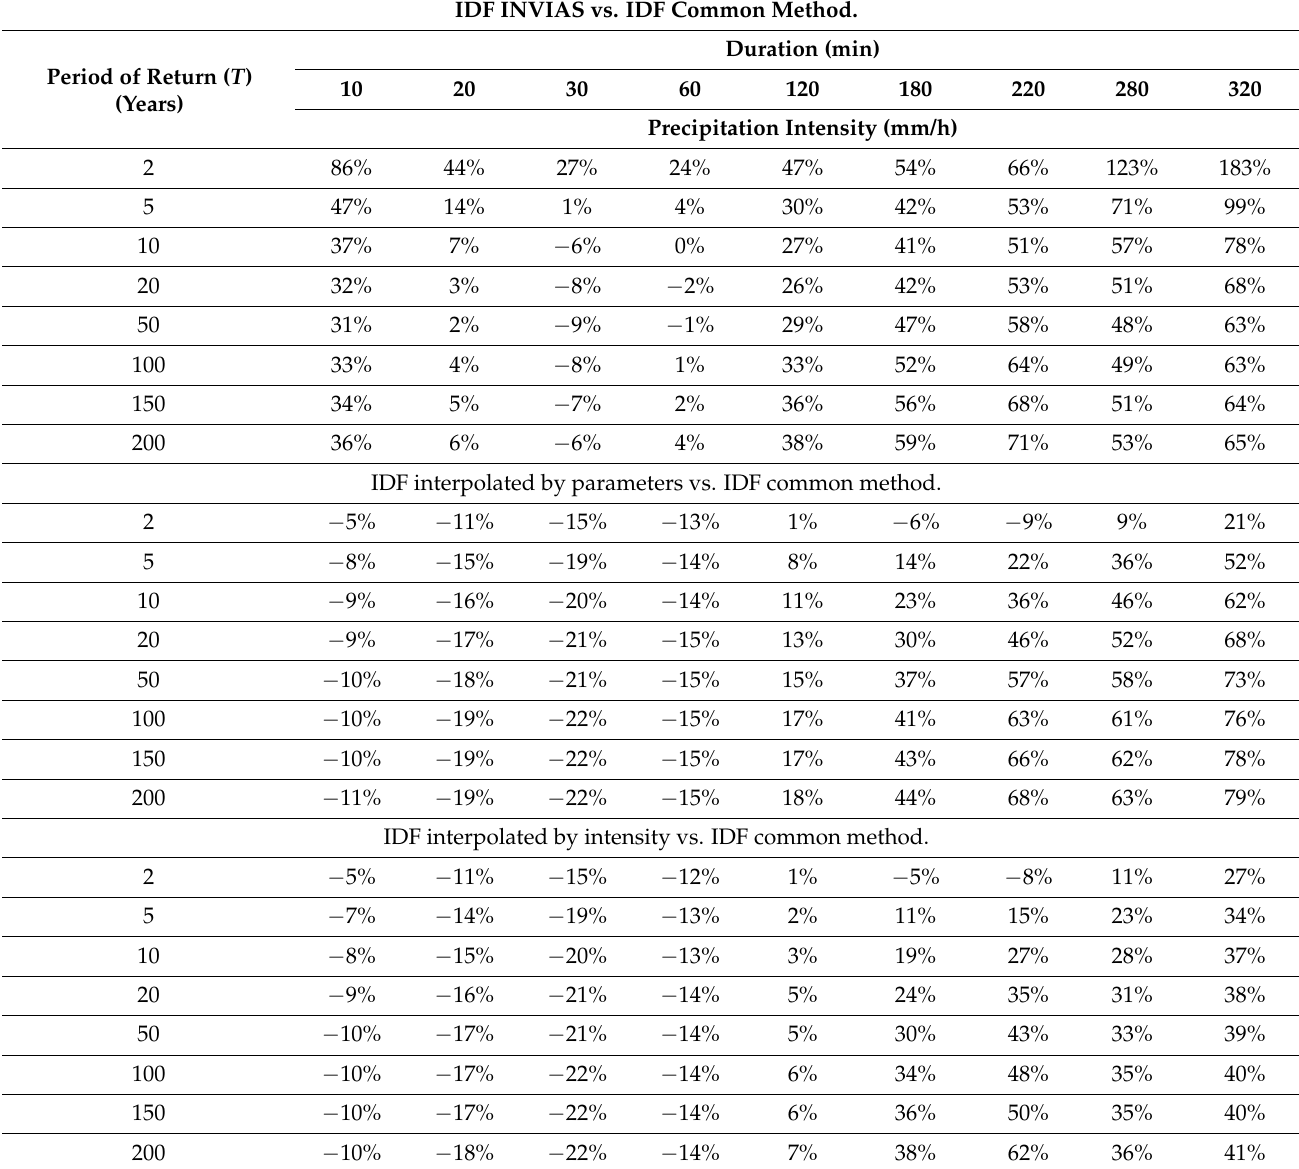
Table 7. Comparison between the method propose in this investigation and the normal or common method and the propose by the INVIAS. IDF INVIAS vs. IDF Common Method.